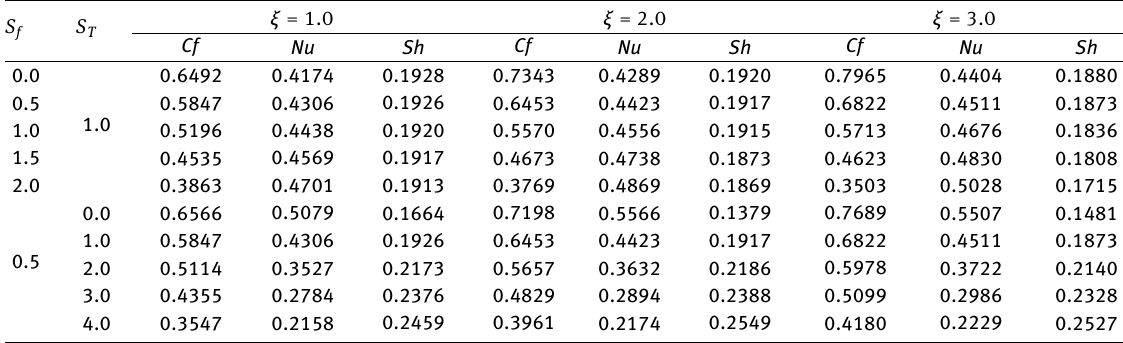
Table 3: Values of skin friction ( Cf ), Nusselt number ( Nu ) and Sherwood number ( Sh ) for different Nb, Nt, M and We